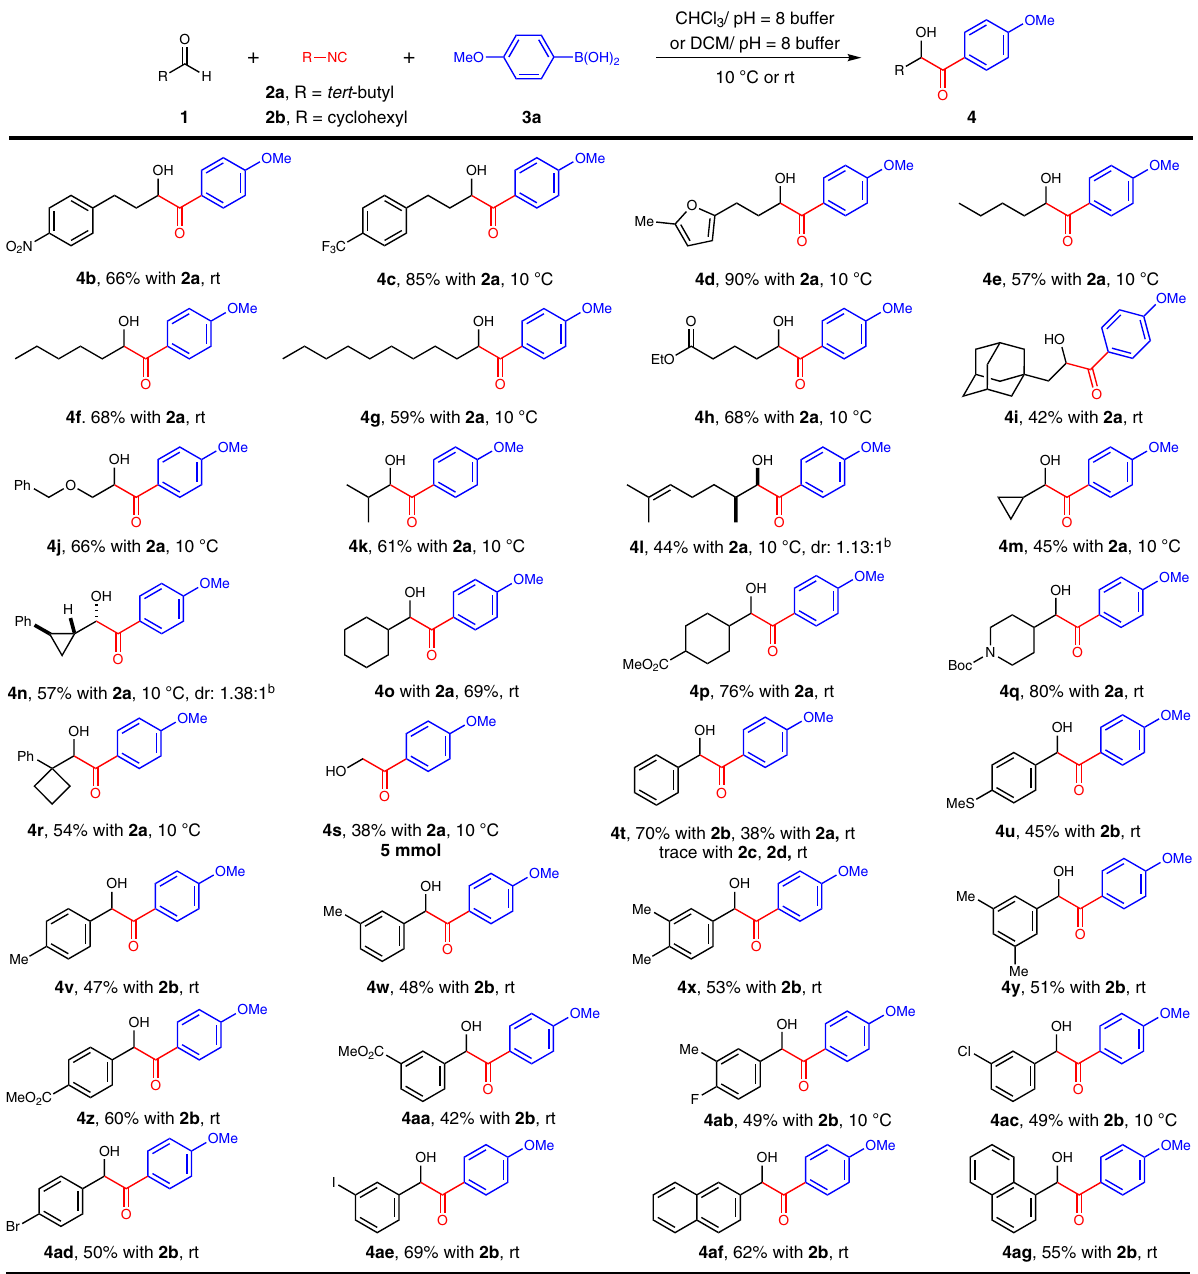
congeners, good reactivities were exhibited. Arylboronic acids with electronically neutral meta-para- dimethyl, para -methyl, and para - tertbutyl substituents produced α - hydroxyketones 5a – 5c in mod- erate yields. Analogs with electron-rich substituents such as acetal, alkoxy, and diphenylamino groups reacted smoothly towards pro- ducts 5d – 5l in 51 – 85% yields. Inclusion of alkenyl or alkynyl group was noteworthy; from which products 5j and 5k were acquired in 80% and 77% yield. This study was auspiciously and effortlessly extendable to a series of heteroarylboronic acids containing furan ( 5m ), thiophene ( 5n – 5p ), benzofuran ( 5q ), benzothiophen ( 5r ), protected or unprotected indoles ( 5s , 5u ), 7-azaindole ( 5t ),